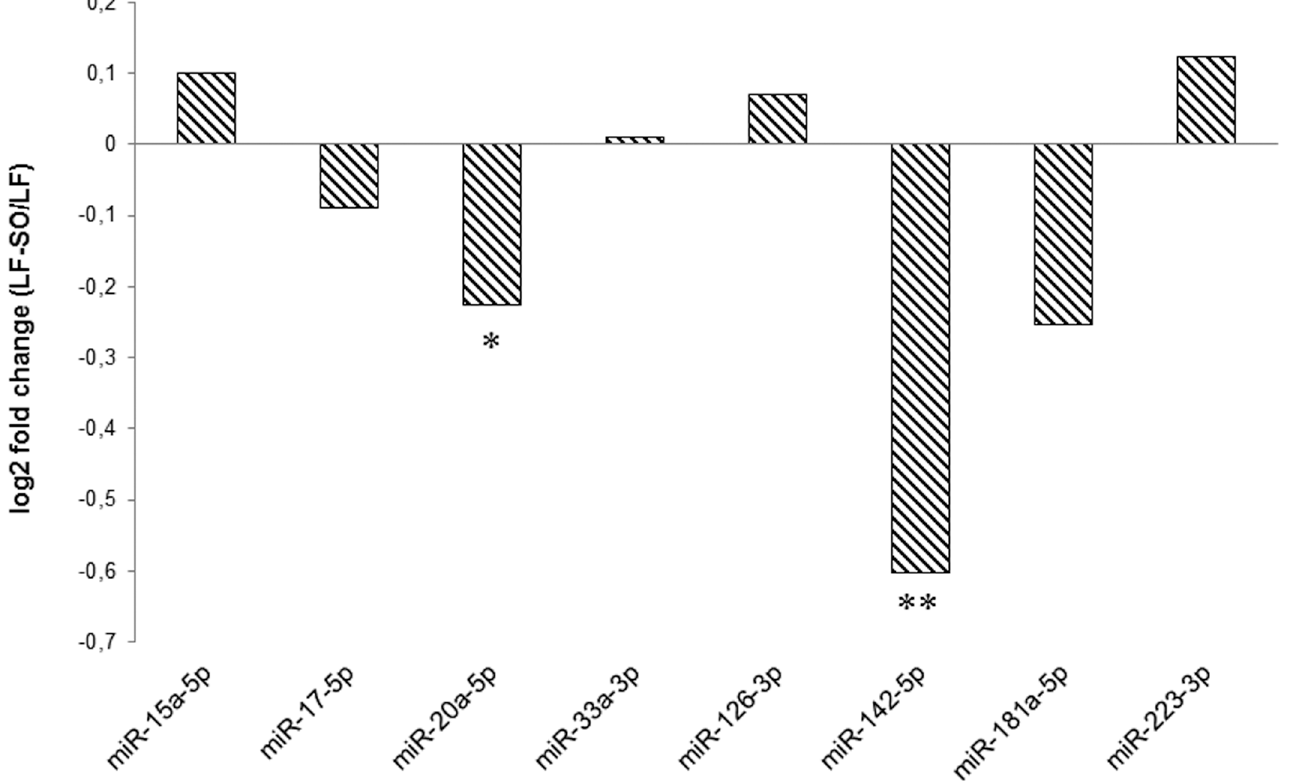
Fig 2. Individual analysis of the expression of eight miRNA in mammary gland. RT-qPCR analyseswere performed from 11 cow received a LF or LF-SO diet. Cows received a low forage diet (LF) or the same diet supplemented with 4% of sunflower oil (LF-SO). ** 0.01 < p < 0.05, * 0.05 < p < 0.1, n =